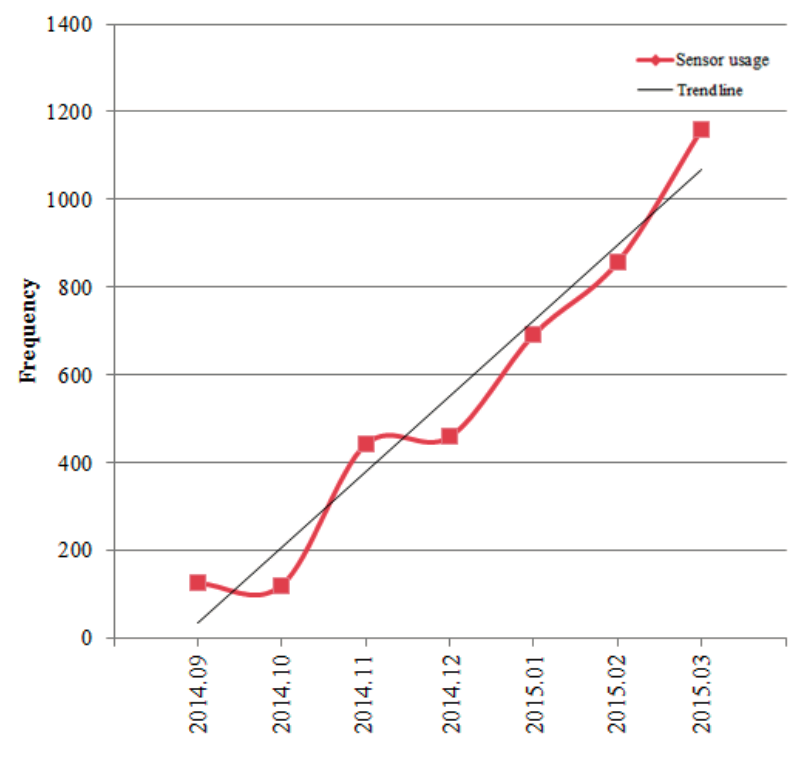
Figure 9. Frequency of usage in mAMIS app by